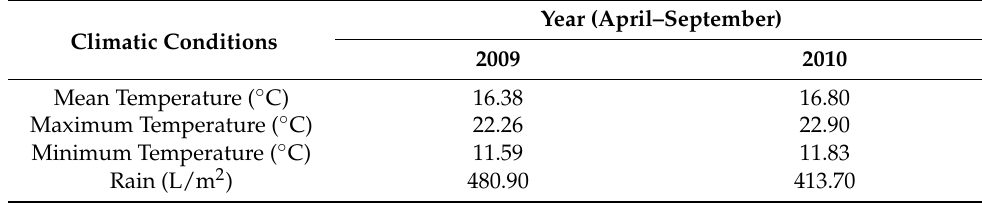
Table 1. Climatic conditions in “Pe Redondo” vineyard from Mart í n C ó dax Winery (NW Spain). Climatic